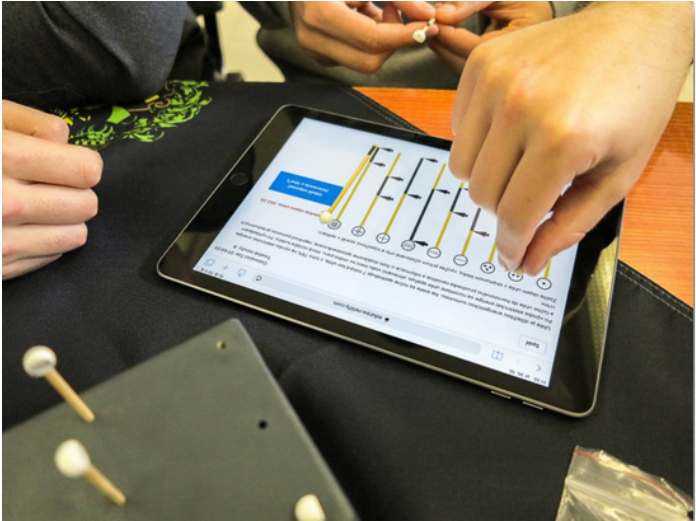
Figure 2. Students using educational toolkit [authors].